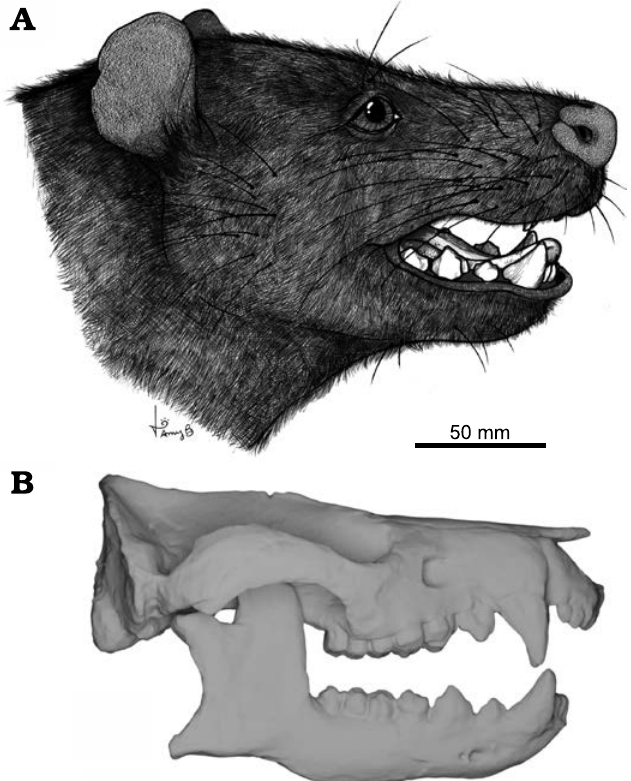
Fig. 1. Reconstruction of cranial eidonomy and osteology of the meridio- lesti dan mammal Peligrotherium tropicalis Bonaparte, Van Valen, and Kramarz, 1993, Punta Peligro, Argentina, Early Paleocene. A . Illustrated life reconstruction (courtesy of Amy Bishop). B . Digitized skull and man- dible reconstructions produced by Paéz-Arango